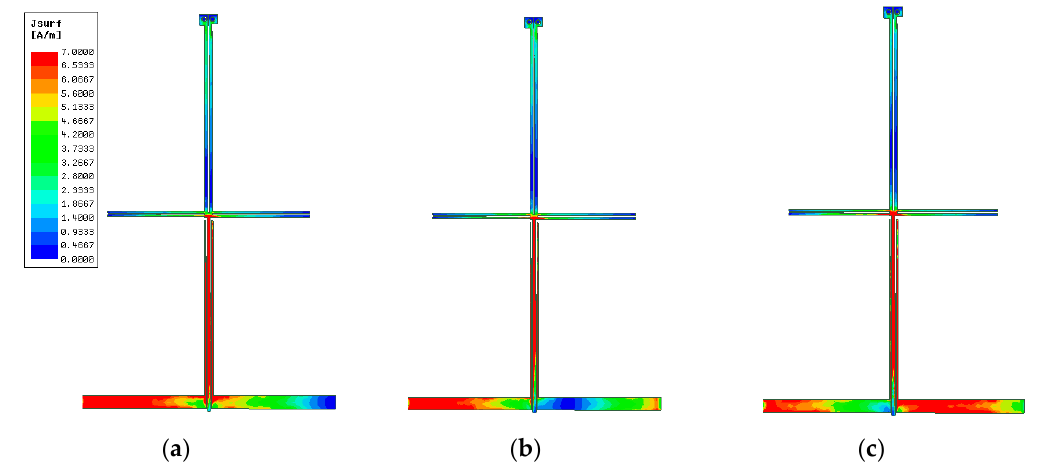
Figure 11. Current density distributions of the proposed bandpass filter at different frequencies: ( a ) 2.5 GHz, ( b ) 2.8 GHz, ( c ) 3.2 GHz.